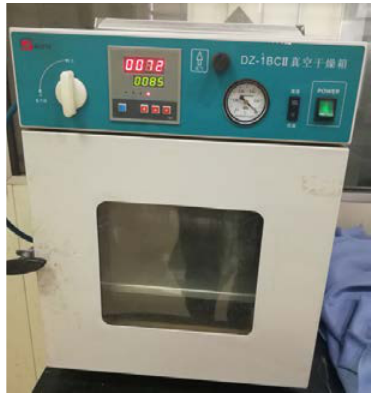
Figure 2. DZ-1BCII vacuum-drying oven.